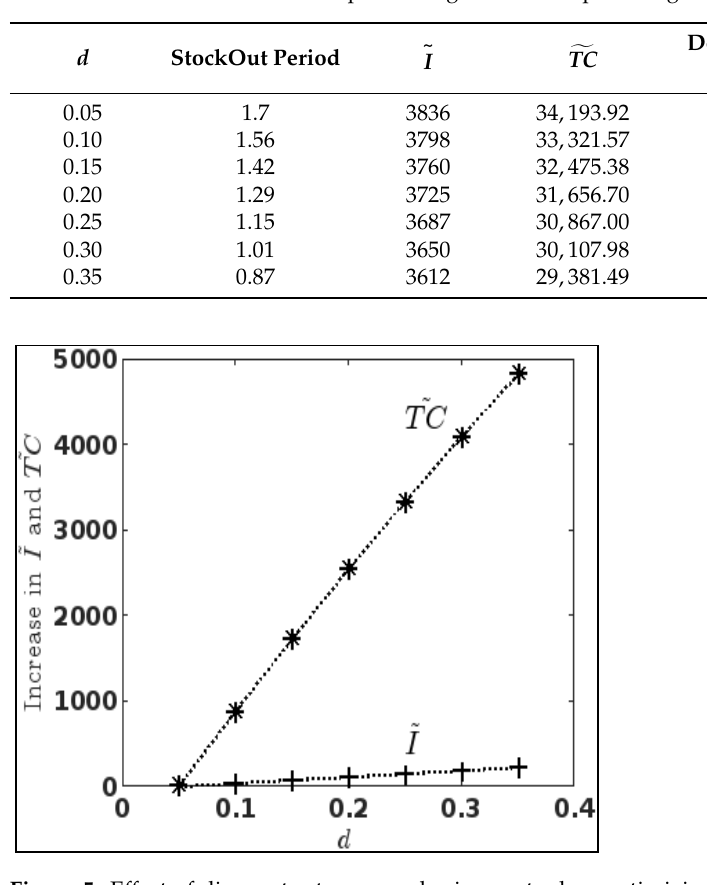
Table 3. Effect of discount rate on purchasing cost when optimizing the total cost.